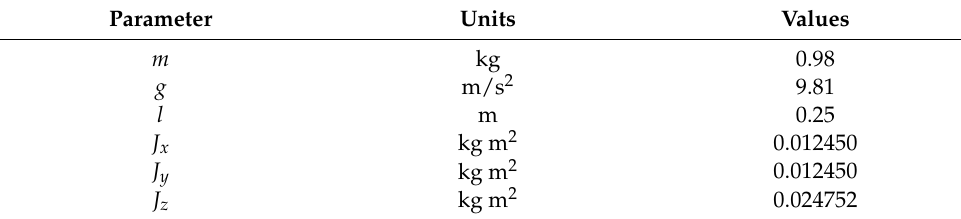
Table 1. Quadrotor system parameters for simulation